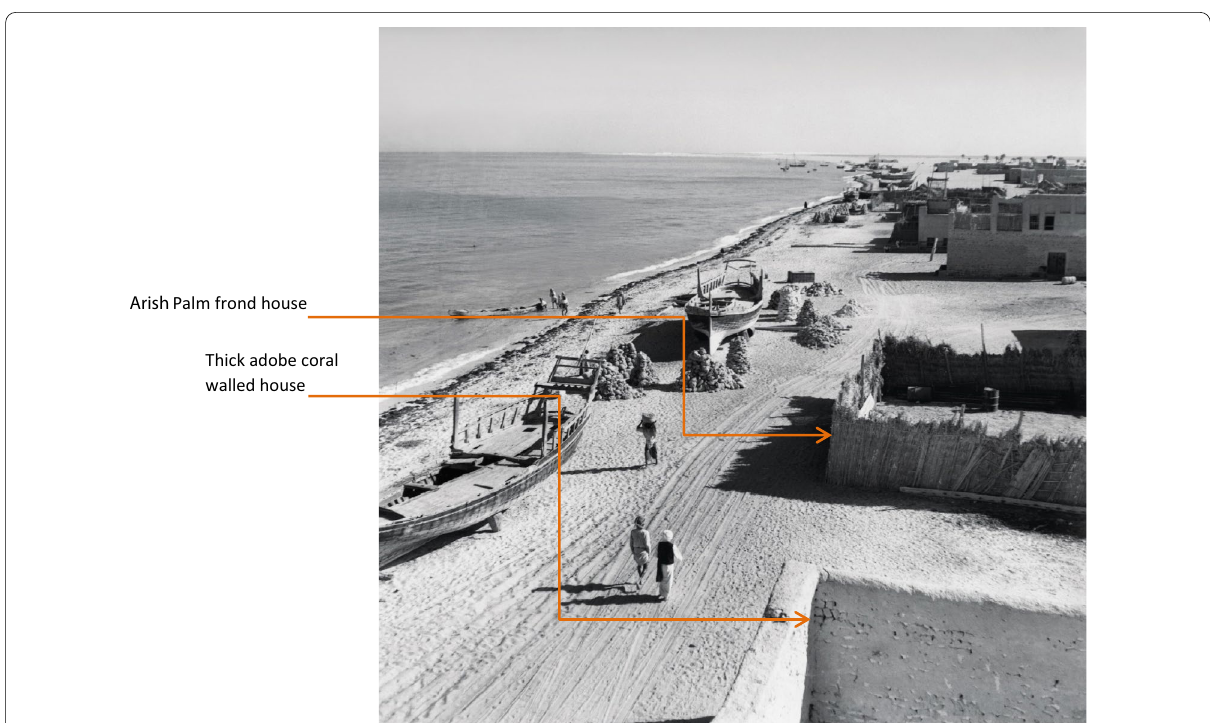
Fig. 1 Coastal house forms of the Abu Dhabi Corniche in 1953. Typical coastal houses were of introverted characteristics and varied in complexity. Source: Used with permission from National Archive UAE ©BP